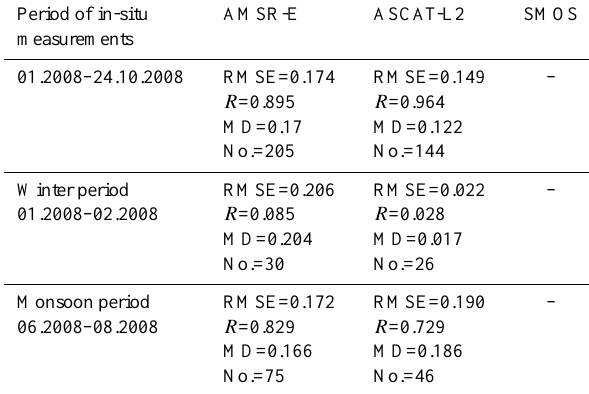
Fig. 4. Volumetric soil moisture and soil temperature at different depths at station CST 01 compared with precipitation data collected at CARRERI/CAS micrometeorological tower. Table 4. Validation statistics data for Naqu network area. RMSE is the Root Mean Squared Error (difference) between a satellite prod- uct and in-situ observation (m 3 m − 3 ) ; R is the coefficient of corre- lation between the previous two (-); and MD is the mean difference between the two (m 3 m − 3 ) . No. is the number of data points